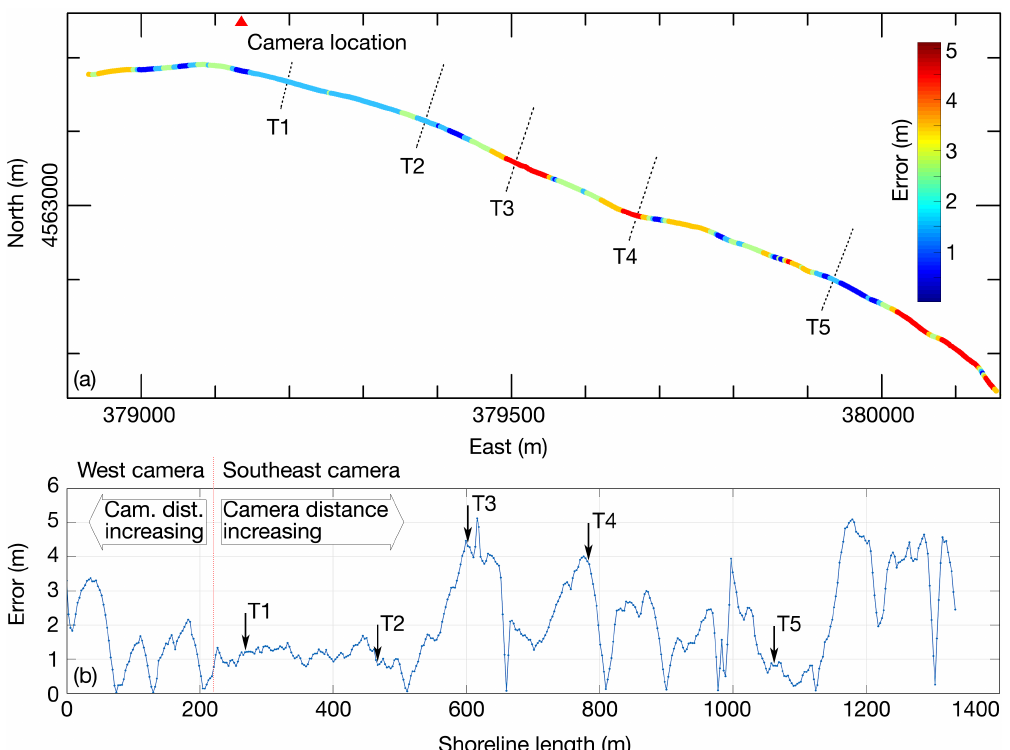
Figure 11. Observed deviations of the video coastline in the normal direction to the DGPS line for about 500 sample points. Panel a shows the deviations in the chromatic scale, in panel b the deviations are reported as function of the shoreline length.